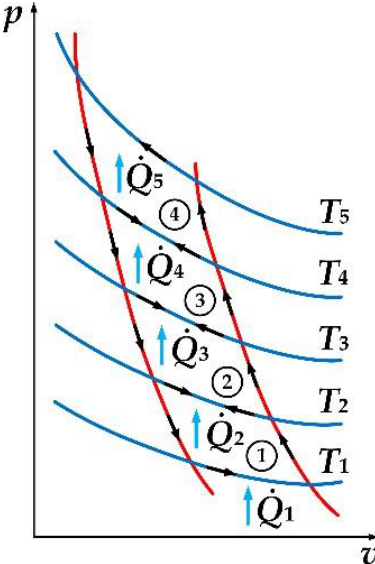
Figure 5. Carnot cycles in the p - v diagram.